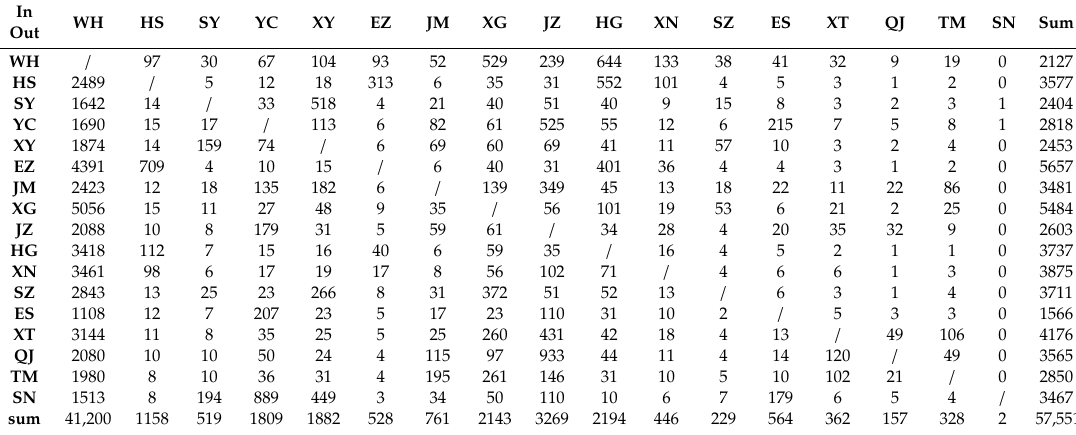
Table 2. The migration index matrix for January 2020 in Hubei province.